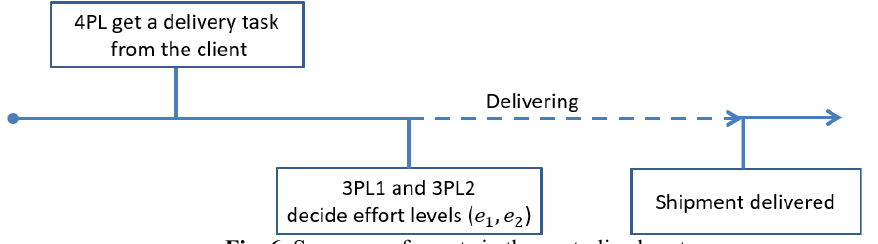
Fig. 6. Sequence of events in the centralized